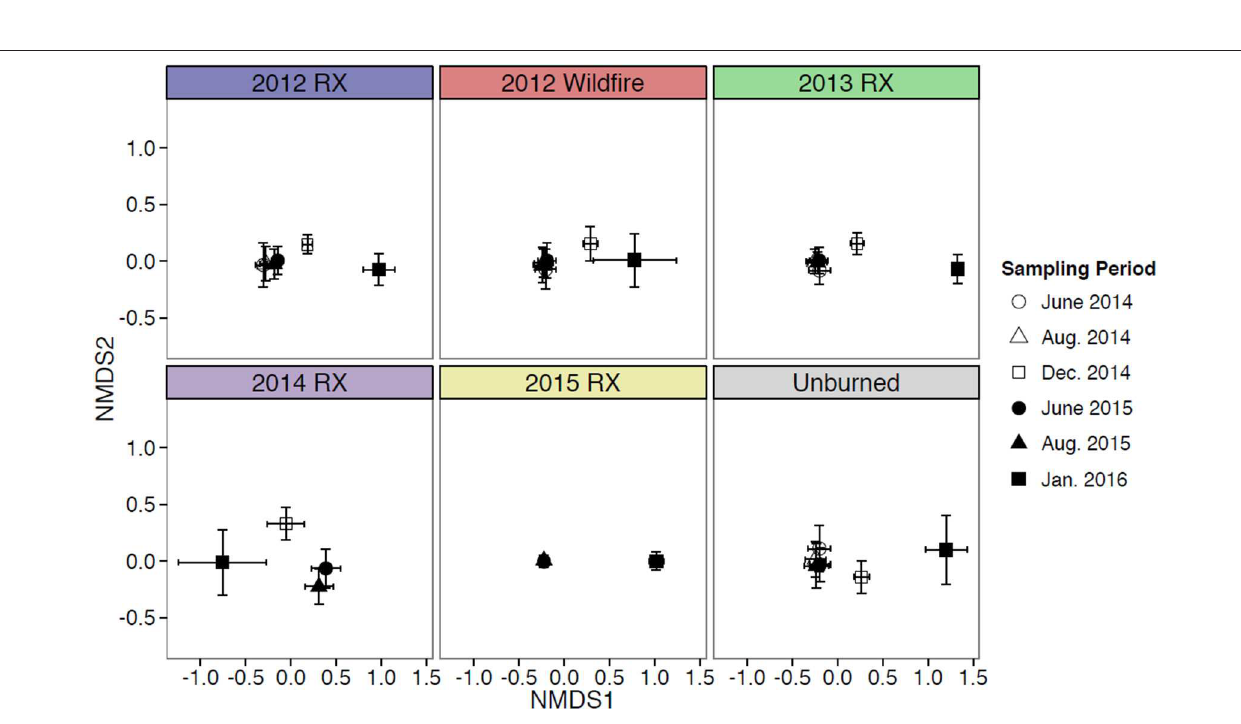
FIGURE 7 | Nonmetric multidimensional scaling (NMDS) ordination of vegetation structural metrics from discrete fire patches in a Nebraska Sandhills grassland managed with patch burning. Shapes within each plot correspond to the six data sampling periods in the early growing, late growing and dormant seasons that were